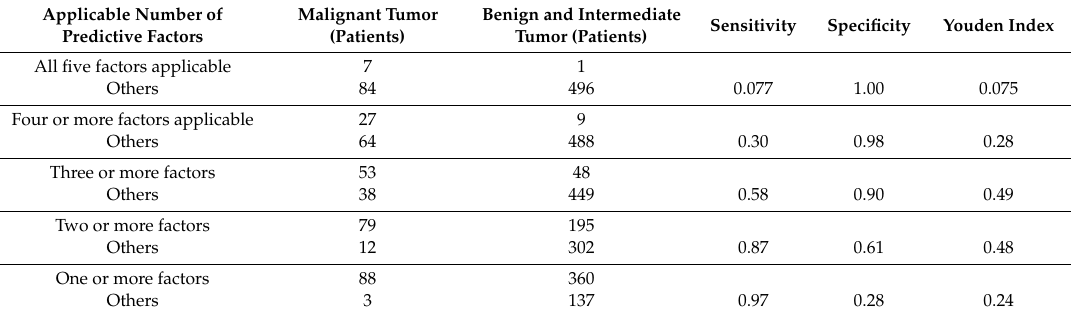
Table 7. Sensitivity and specificity according to the applicable number of predictive